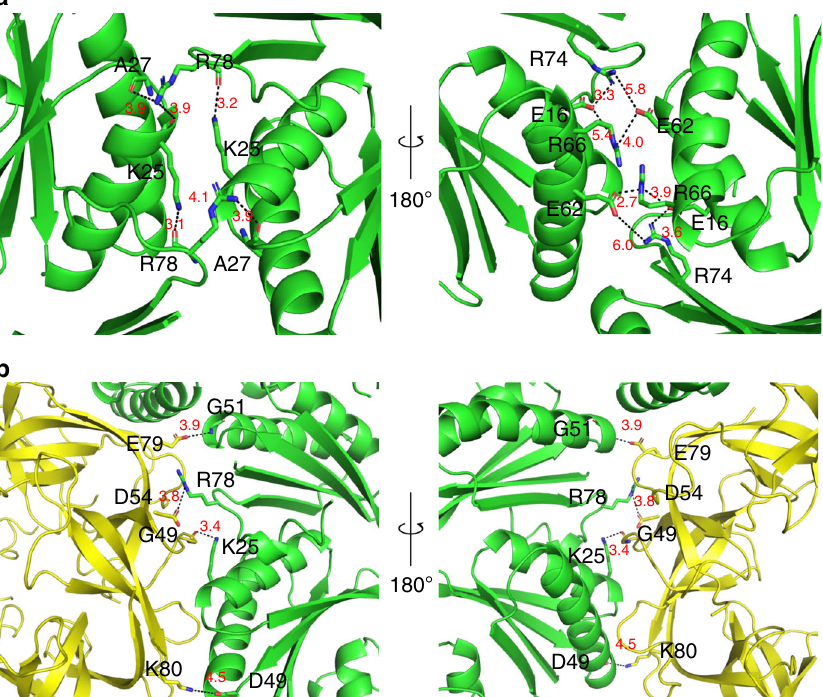
Fig. 6 Detailed view of hexameric – hexameric and pentameric – hexameric interfaces. a Hexameric – hexameric cmcC ′ – cmcC ′ interface; K – R – X (in our case K – R – A) triad and salt bridge networks are viewed as stick models, distances are measured in angstroms. b Hexameric – pentameric cmcC ′ – cmcD interface; amino acids involved in contacts are viewed as stick models. Distances are measured in